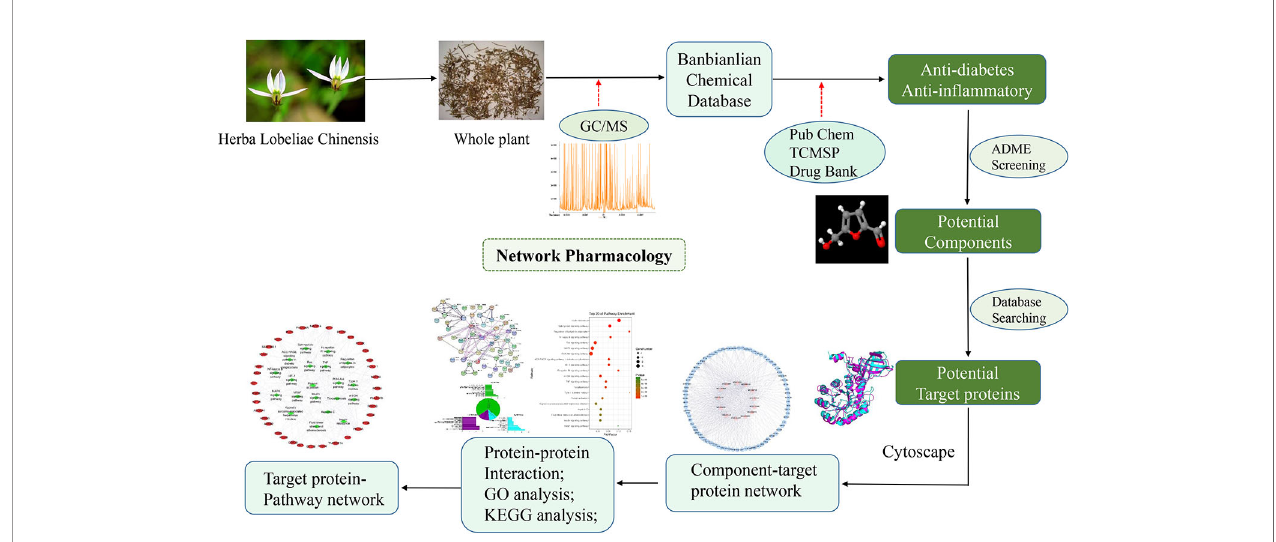
FIGURE 1 | The fl owchart of the network pharmacological analysis